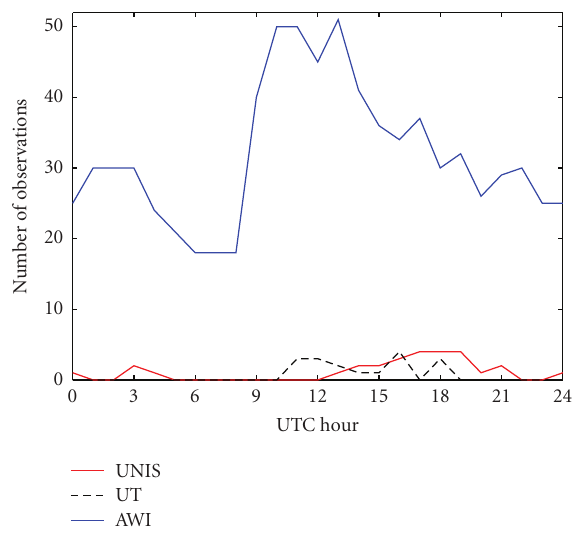
Figure 3: Diurnal distribution of tethersonde